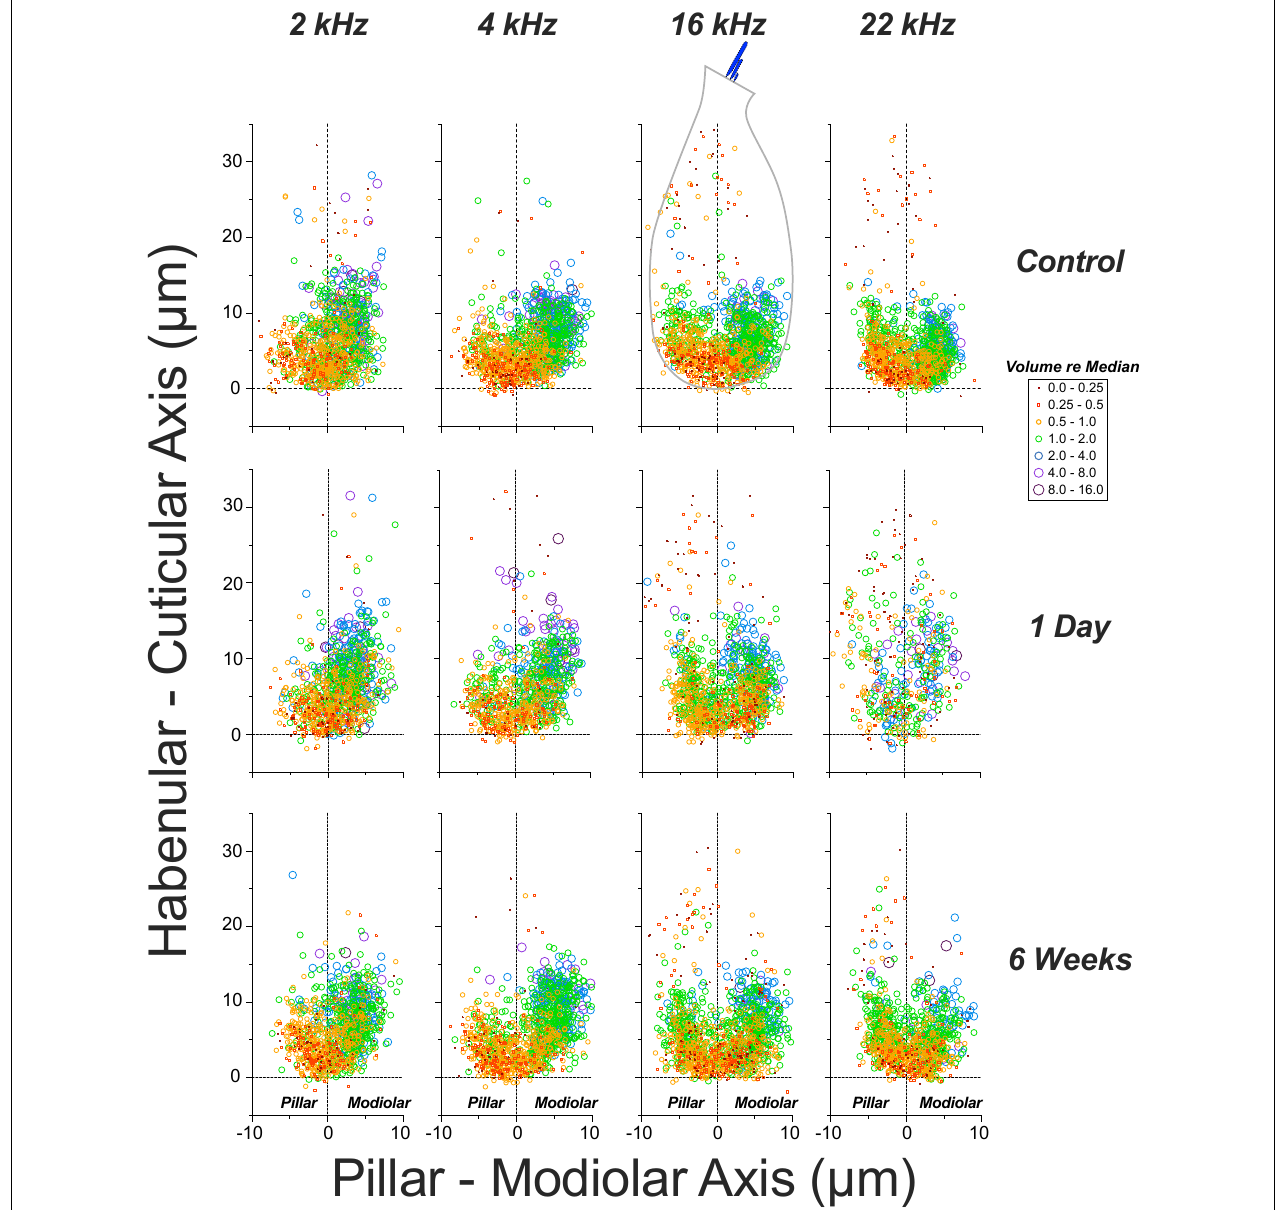
FIGURE 8 | The normal ribbon-size gradient in IHCs is severely disrupted 1 day post noise, but has largely recovered 6 weeks later. Panels are organized into columns by cochlear frequency, and into rows by post-exposure time, as indicated. The locations of synaptic ribbons are shown along hair-cell-relative axes (see Figure 6D and dashed outline of 16 kHz controls for orientation): ribbon size is indicated by color and symbol size, as indicated in the key: size is normalized to the median value in each confocal z-stack. Each panel includes data from 2 image stacks (averaging 9.7 IHCs per stack – see Figures 6A,B ) at each cochlear location from each ear. Data from 4 ears from 4 animals in control and 1-day group, and 4 ears from 2 animals in the 6-weeks-post-exposure